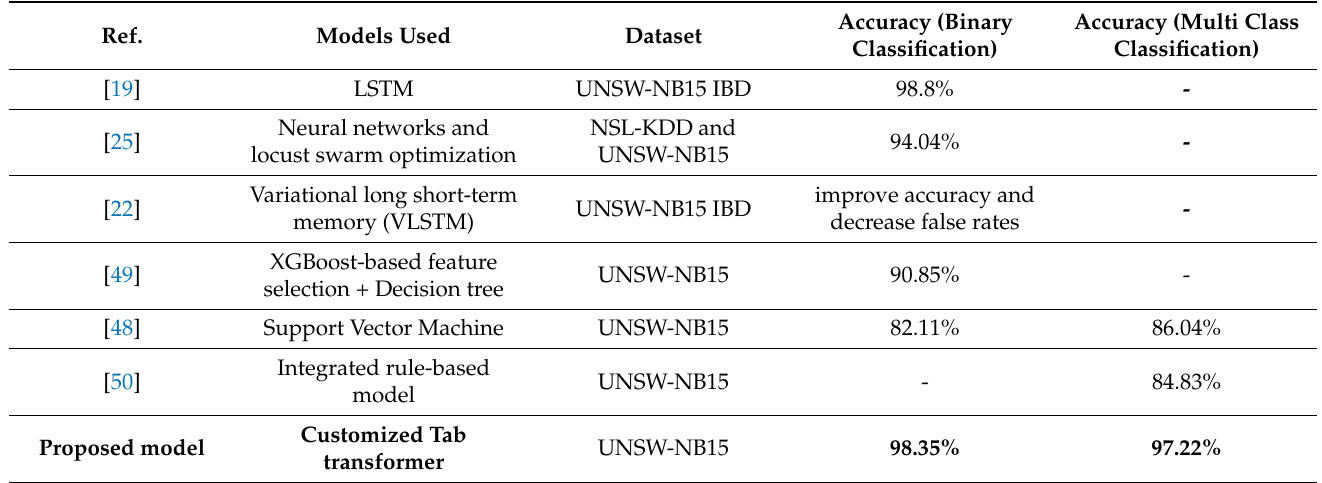
Table 8. Comparison of the proposed model with the previously developed anomaly/intrusion detection